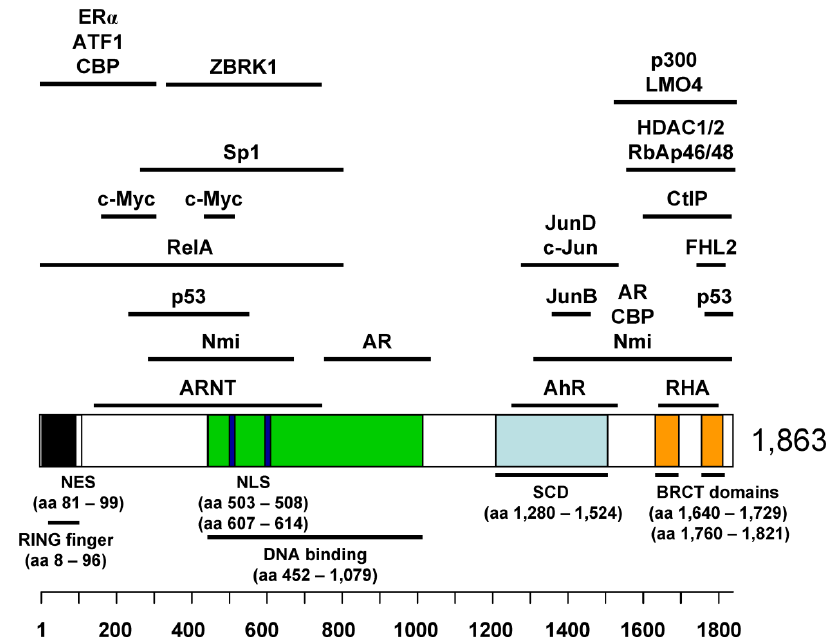
Figure 1. The BRCA1 protein and its binding transcription